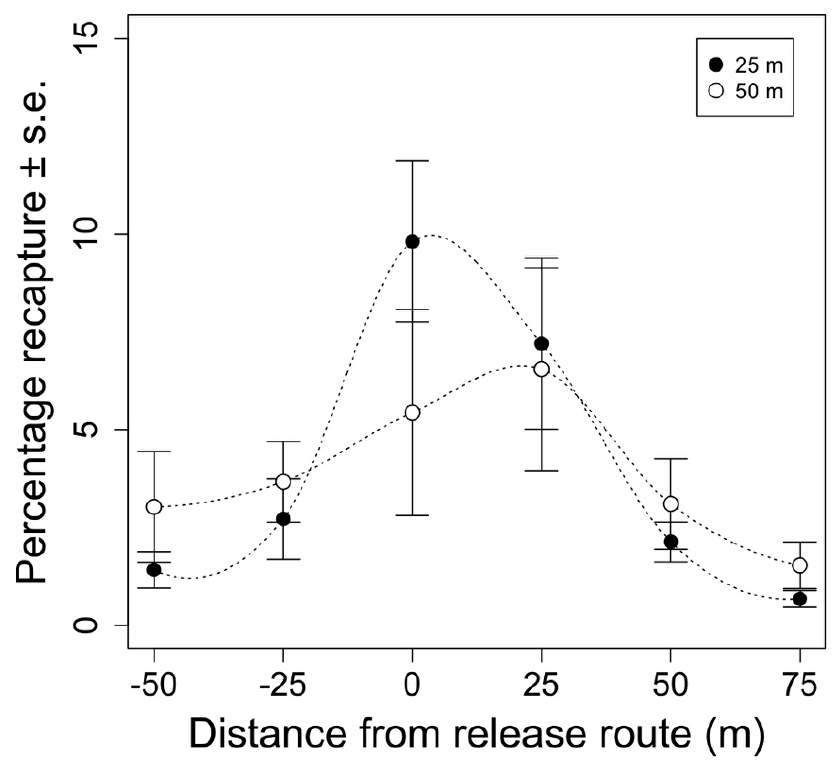
Figure 3. Mean percentage of recaptured moths vs. distance from the aerial release route (m). Each distance from the release route represents the sum of 11 traps in the grid at the specified distance from the release route for each replicate. Points represent week-long total recaptures averaged across replicates ± 1 standard error for each distance ( n = 6). Black and white points represent recaptures of moths that were release from 25 or 50 m above ground, respectively.